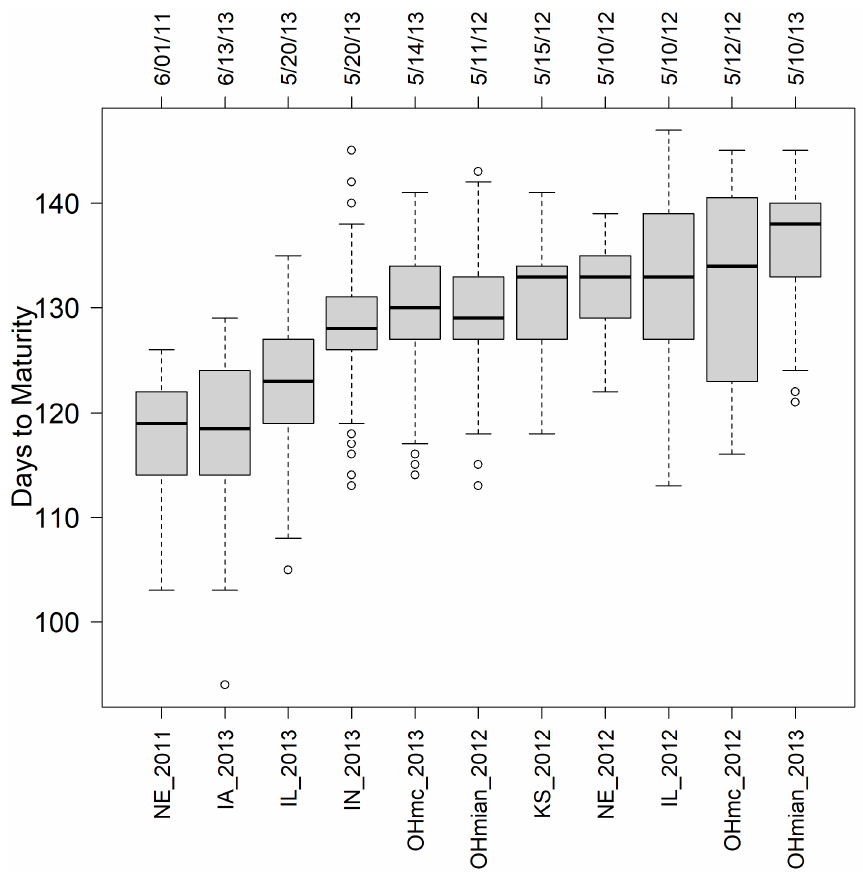
Figure 3. Boxplot of DTM ( y -axis) in 11 environments ( x -axis) for 367 genotypes tested in the US North-Central Region. The planting dates at each site appear at the top.